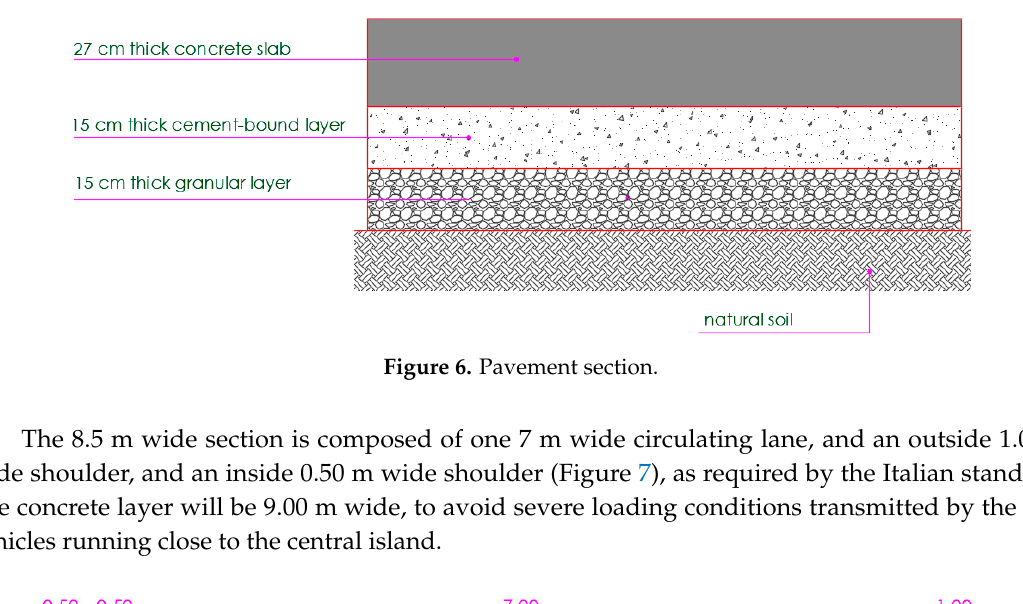
Figure 7. Cross section of circulatory roadway (unit of measure: m).